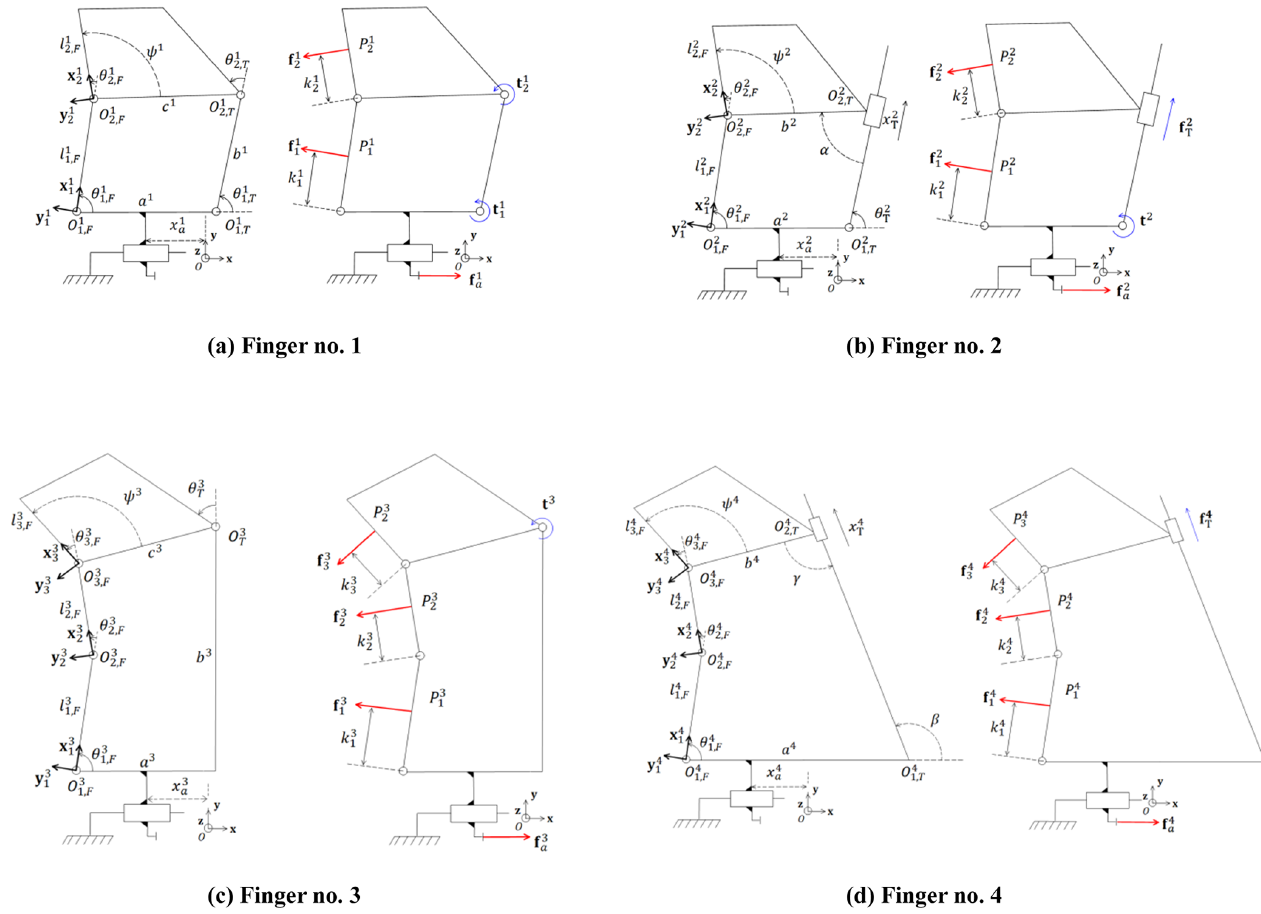
Figure 3. The four 1DOF self-adaptive fingers proposed in this paper. Table 1. Summary of the main parameters of the fingers. Finger Phalanx number/ Transmission Transmission Contact Passive force Transmission variables joint number/ joint type force and torque linkage geometric variables vectors magnitudes